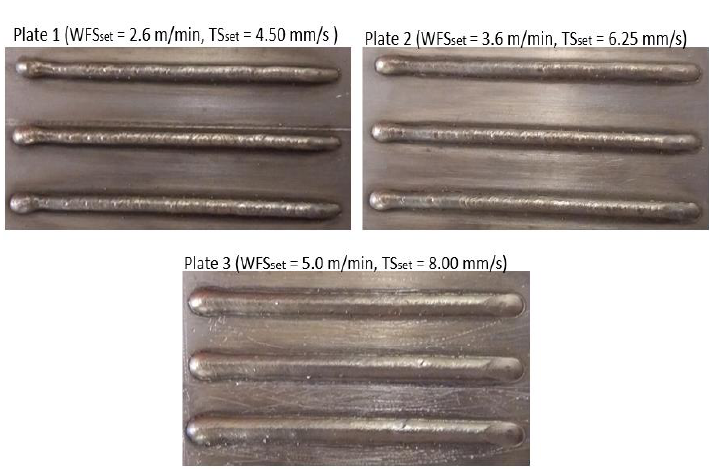
Figure 8. Samples used in the experiments to determine DR e for the working currents. Table 4. Calibration of WFS and determination of DR for each selected current.